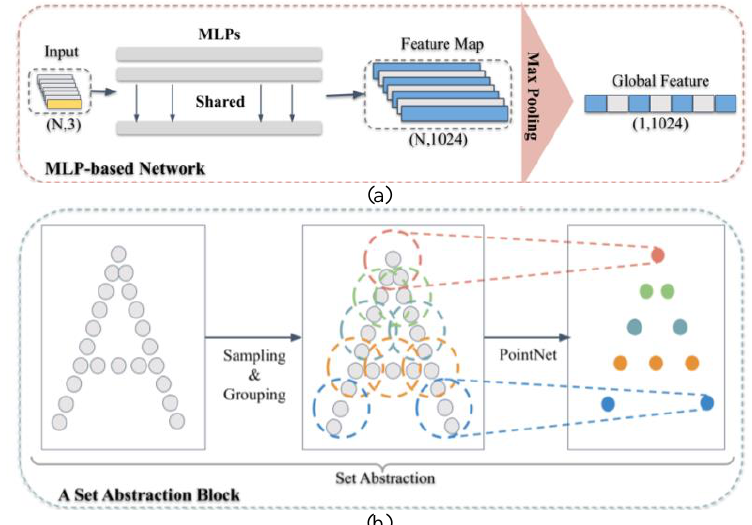
Figure 2. An illustration of PointNet (Qi et al., 2017a) and PointNet++ (Qi et al., 2017b). Top: a demonstration of how to use multilayer perceptron (MLP) layers to learn pointwise features and utilise a max pooling layer to learn and aggregate the global features in PointNet. Bottom: a 2D explanation of how to use a Set Abstract block in PointNet++ to sample, group, and extract local geometric information from input points and their neighbours.